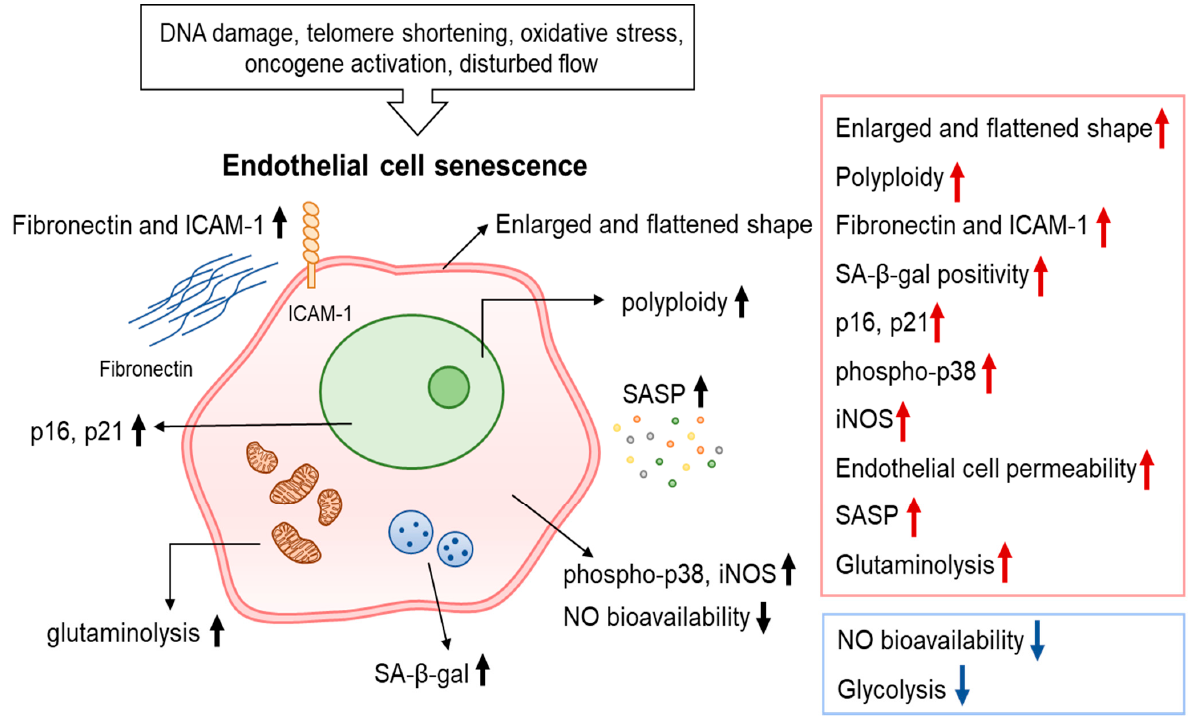
Figure 1. Characteristics of senescent endothelial cells. Various stimuli including DNA damage, telomere shortening, disturbed flow induce endothelial cell (EC) senescence. EC senescence is a state of indefinite cell cycle arrest accompanied by multiple biochemical and metabolic changes. Senescent cells generally become enlarged and flattened and display increased polyploidy, SA- β -gal activity, permeability, phosphorylation of p38, and expression of p16/p21. In addition, senescent ECs display elevated fibronectin, ICAM-1, and iNOS and reduced of NO bioavailability. Senescent ECs also produce a complex and unique SASP that includes secretion of IL-8, IL-6, PAI-1, MCP-1, IGFBP-5, and CXCL11. The metabolic alterations of senescent ECs include reduced glycolysis and increased